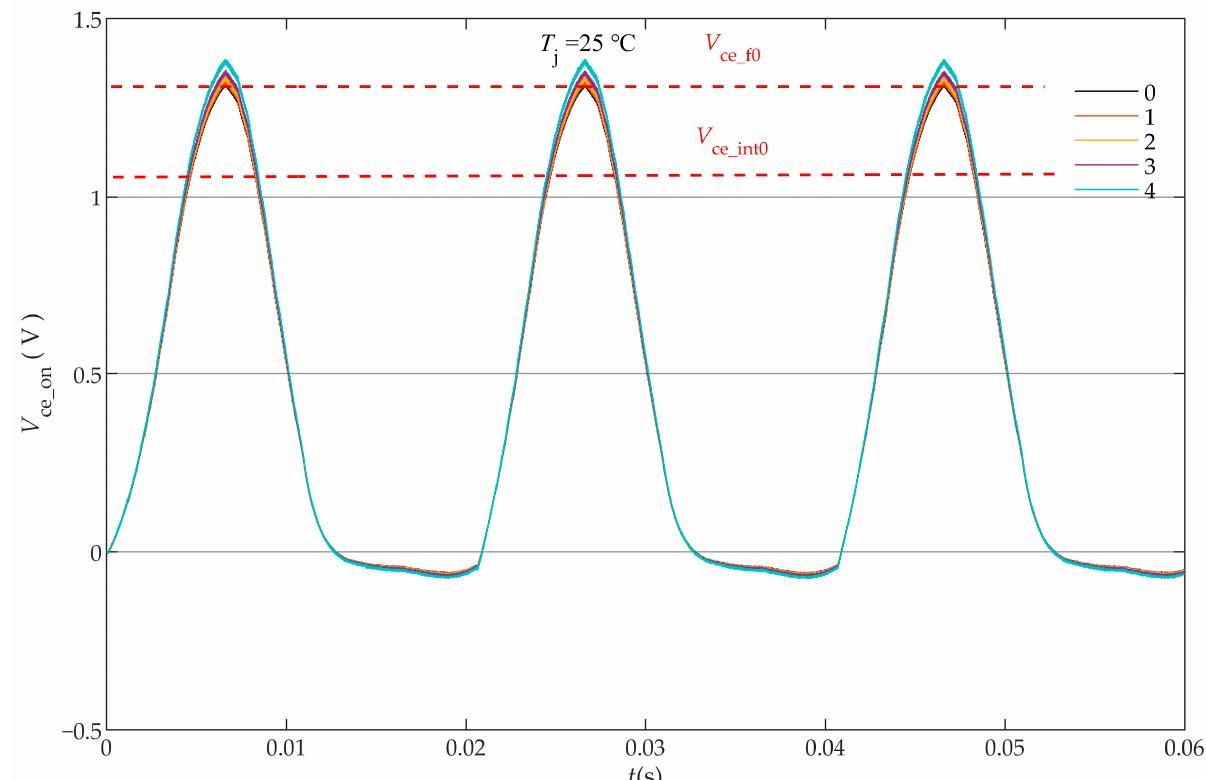
Figure 7. Online monitoring results with different broken bond wires in the case of T j = 25 °C.